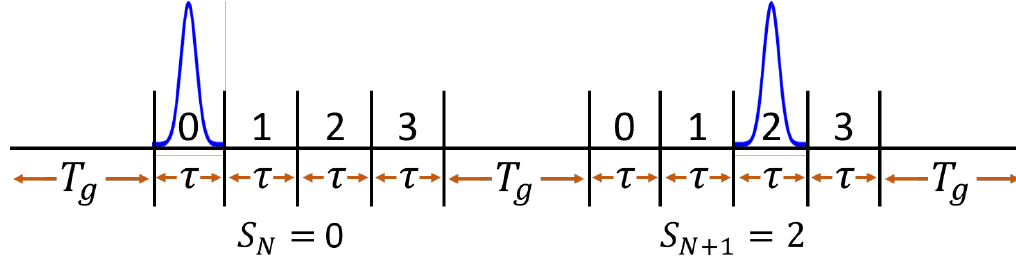
Figure 1. Example string of pulse position modulation (PPM) where the first symbol transmitted (S N ) encodes a “0” and the second symbol (S N + 1 ) encodes a